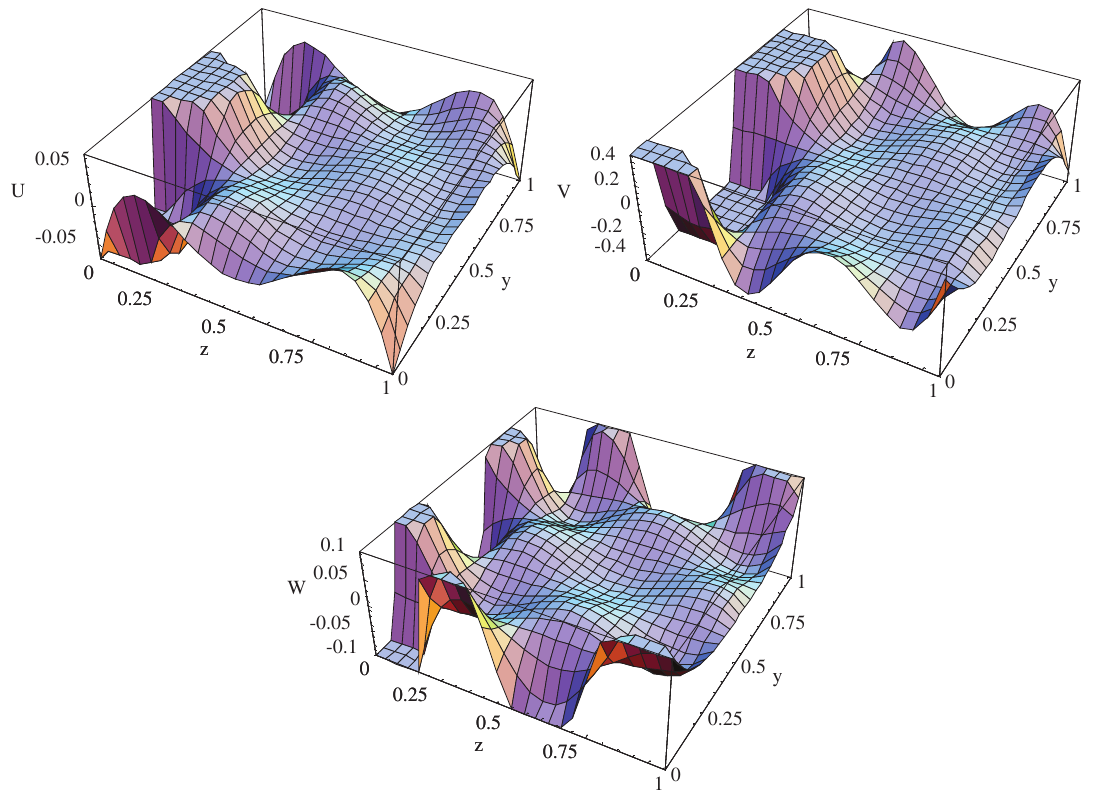
Figure 6: Displacement shapes of the fourth mode for the linearly FGPP square bar at kd = 90.1.